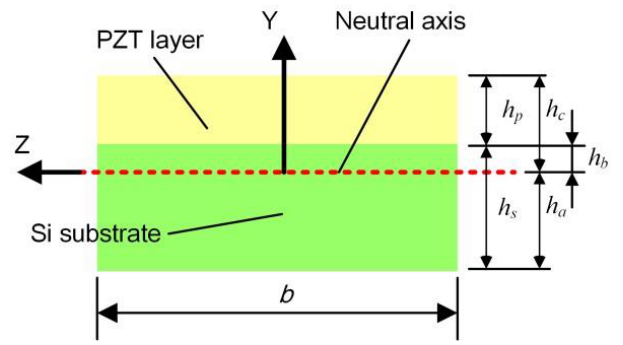
Figure 5. The cross-section of the piezoelectric composite cantilever beam. The d-type constitutive equation of piezoelectric materials describes the conversion relationship between mechanical and electrical energy. This equation includes stress T